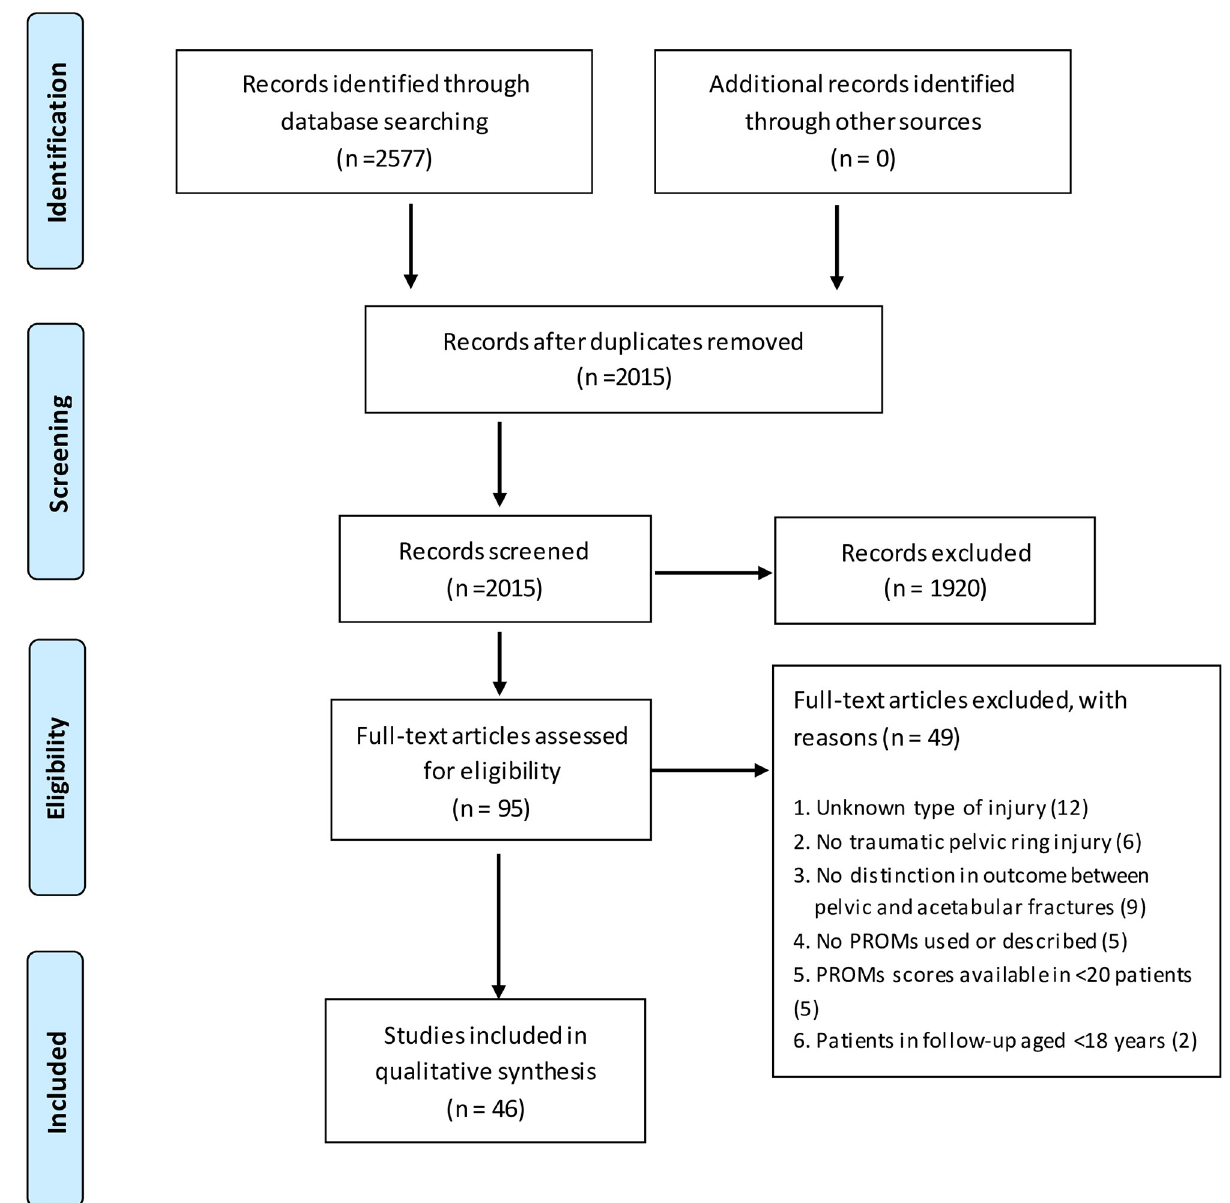
Fig 1. Flow diagram according to the PRISMA